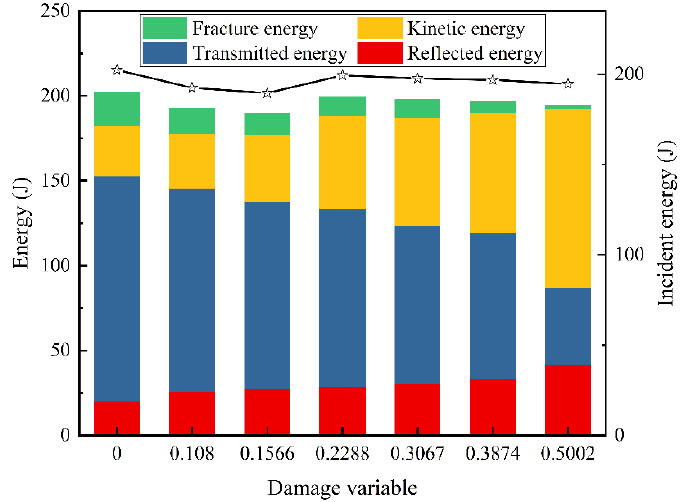
Figure 17. Variation of fragments velocity and kinetic energy with accumulated damage variable.